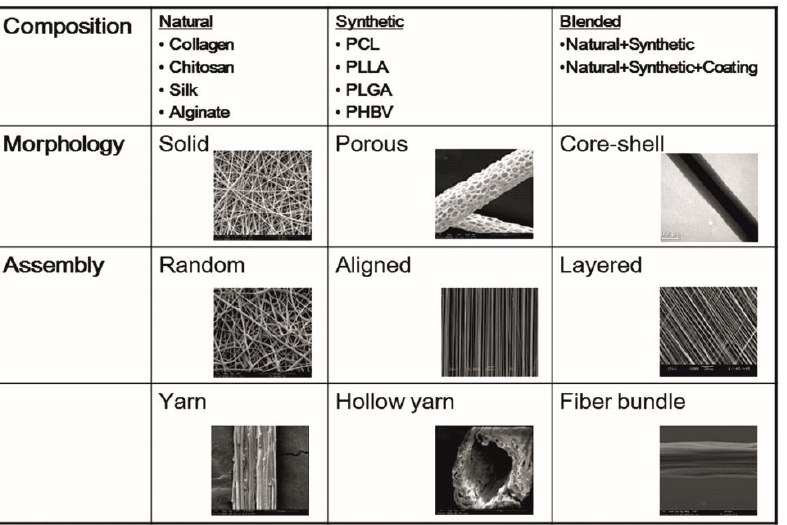
Figure 2. Patterns of the electrospun nanofibers categorized. Nanofibers can be electrospun in different formats such as random, aligned and layered depending on the instrumentation. Figure formatted with permission (NUSNNI, NUS) .